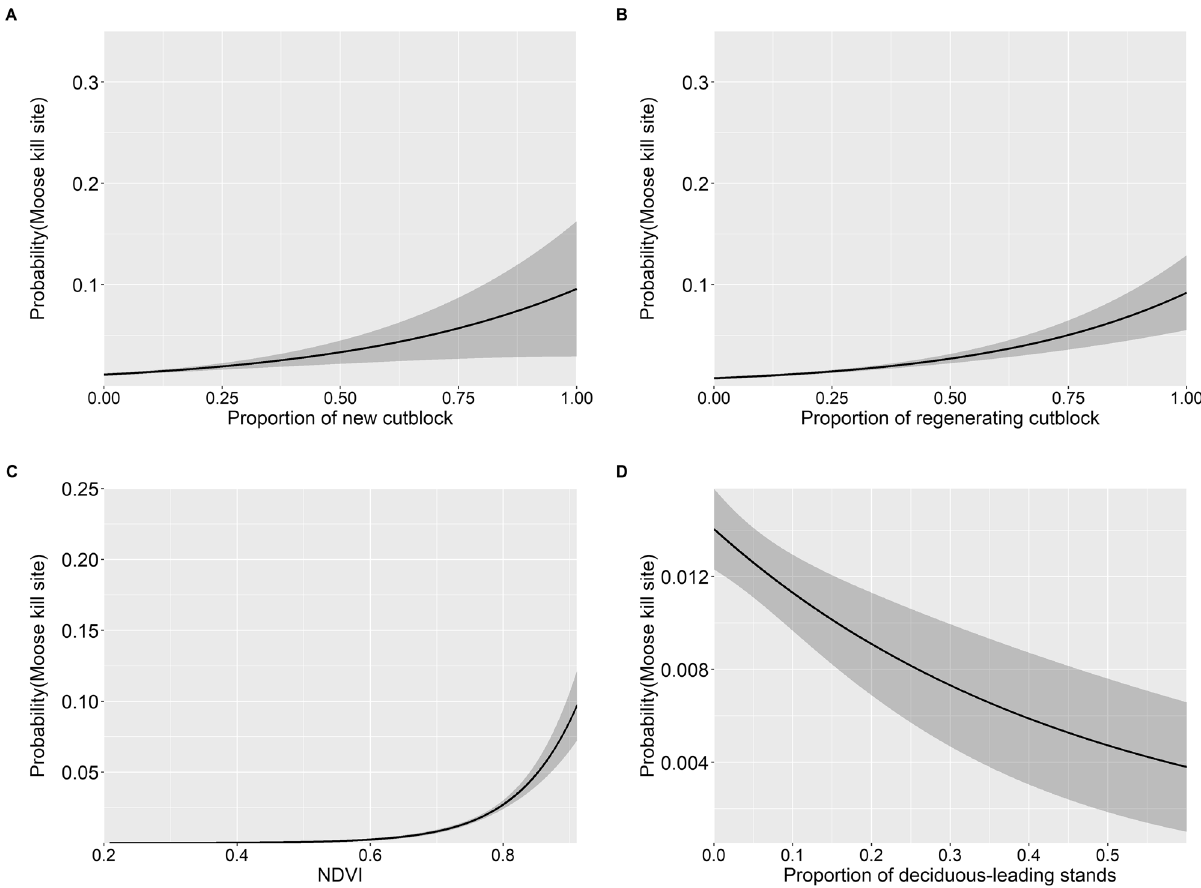
Figure 5. Predicted probability with 95% confidence intervals of a wolf kill-site of a moose occurring based on ( A ) proportion of new (0–8 years old) cutblocks, ( B ) proportion of regenerating (9–24 years old) cutblocks, and ( C ) mean normalized difference vegetation index (NDVI), and ( D ) proportion of deciduous-leading stands within a 883 m buffer around the location, in Prince George South, 2018–2020.